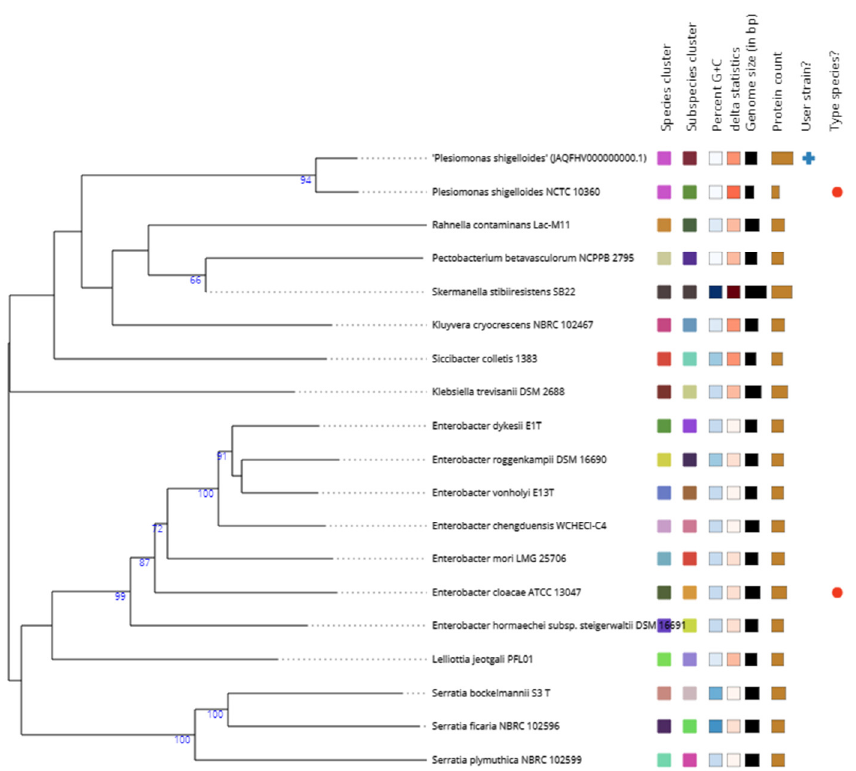
Figure 1. Tree inferred with FastME 2.1.6.1 with GBDP distances calculated from genome sequences. The branch lengths are scaled in terms of the GBDP distance formula d5. The numbers above branches are GBDP pseudo-bootstrap support values, >60% from 100 replications, with an average branch support of 65.1%. The tree was rooted at the midpoint.